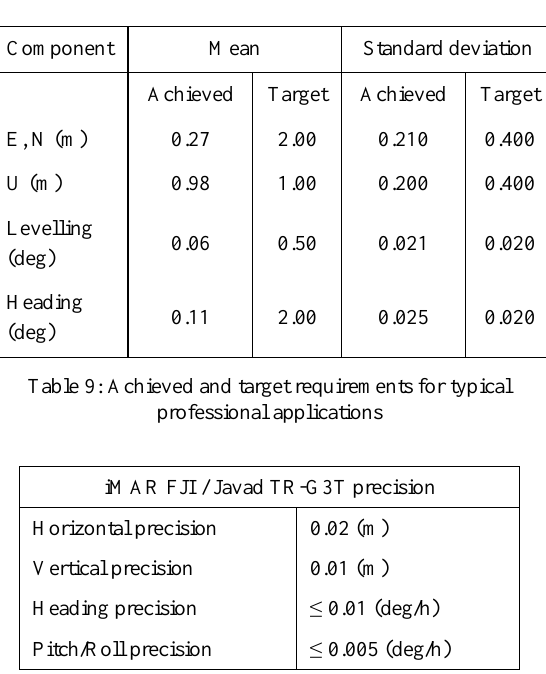
Table 10: Precision of the combined iMAR FJI / Javad TR-G3T reference